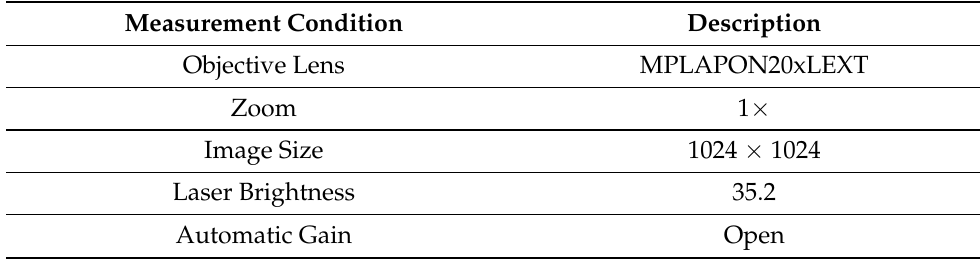
Table 3. Measurement